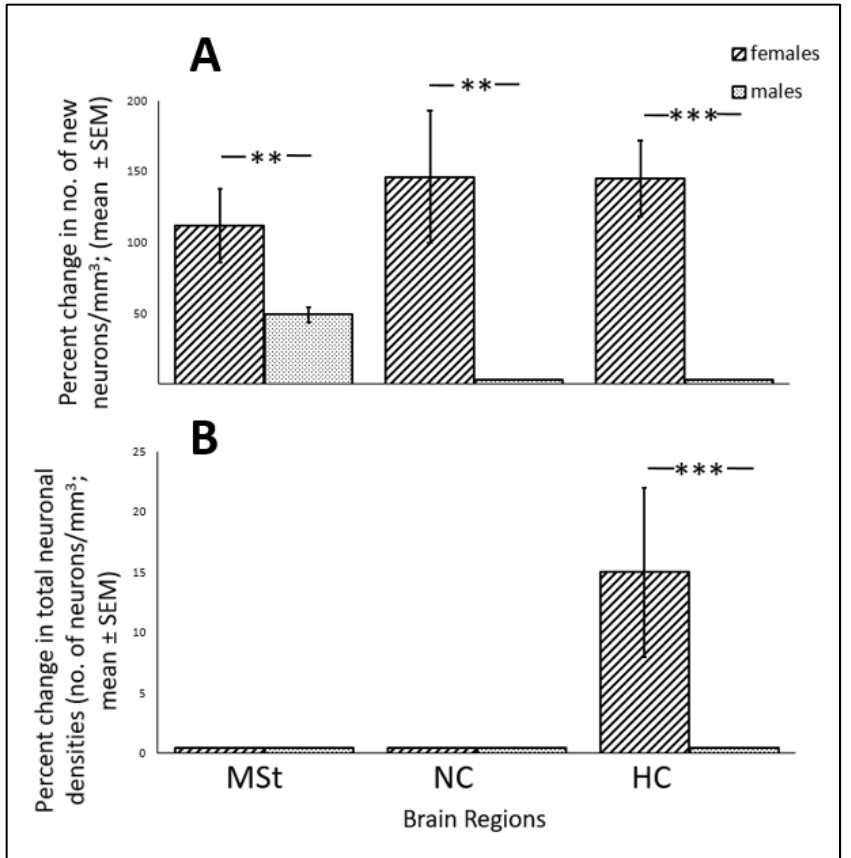
Figure 10. ( A ) Percent change in neuronal recruitment (number of new neurons/mm 3 ; mean ± SE) compared to corresponding control, and ( B ) percent change in total neuronal densities (number of neurons/mm 3 ± SE), in MSt, NC and HC, in brains of female and male zebra finches exposed to 5 lux ALAN for 6 weeks. Female data taken from [7]. N = 8 for each sex. **, ***—indicate significant dif- ferences ( p < 0.005, and p < 0.0005 respectively; Tukey post hoc tests following one-way ANOVAs for each section separately).